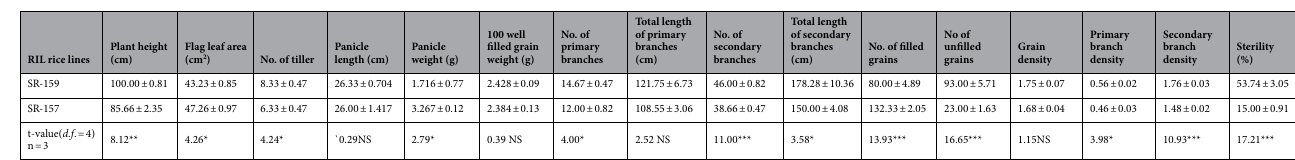
Table 1. Plant morphology and grain yield parameters of panicle on main shoot of two RIL rice lines SR-159 (sterile) and SR-157 (fertile) grown in the field conditions at NRRI, Cuttack during the wet season of 2017. The values are means of three replicates (n = 3) and ± values indicate standard